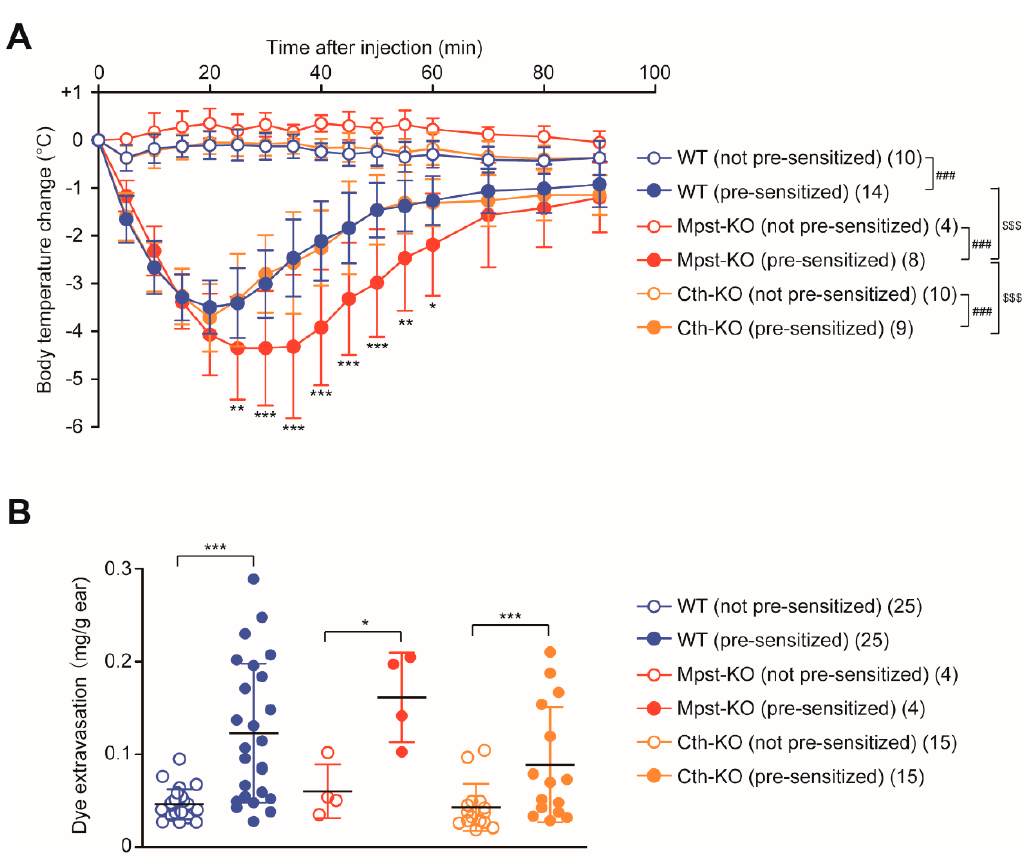
Figure 5. Hepatic Altered passive anaphylaxis (PSA but not PCA) in Mpst-KO mice. ( A ) Analysis of rectal temperatures in IgE-antigen-dependent PSA for WT, Mpst (1st)-KO, and Cth-KO mice after antigen challenge. Di ff erences between pre-sensitized versus not pre-sensitized (vehicle alone) measurements were significant at ### p < 0.001 as well as those between genotypes at $$$ p < 0.001 in a two-way repeated-measured ANOVA with Bonferroni’s multiple comparison test (Di ff erences in each time point were significant at * p < 0.05, ** p < 0.01, and *** p < 0.001). ( B ) Analysis of ear edema in IgE-antigen-induced PCA in WT, Mpst-KO, and Cth-KO mice after antigen challenge. Di ff erences in Evans blue dye extravasation between left (not pre-sensitized) and right ears (pre-sensitized with anti-DNP IgE) were evaluated. The ratio di ff erences were significant (* p < 0.05 and *** p < 0.001, pre-sensitized versus not pre-sensitized) in ratio paired t -tests. Di ff erences in the ratios were not significant between the genotypes in a one-way ANOVA with Tukey’s multiple comparison test.